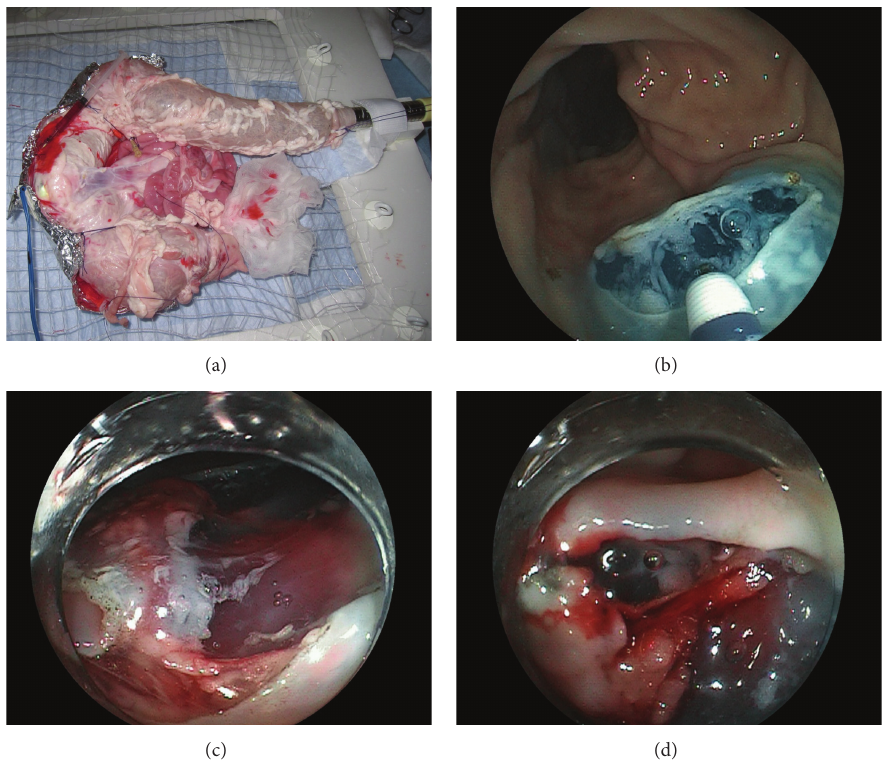
Figure 8: (a) Ex vivo blood flow animal model (Johnson & Johnson, Tokyo, Japan) for training for endoscopic hemostasis in colorectal endoscopic submucosal dissection. (b) Submucosal dissection was performed. (c) In the ex vivo blood flow model (bovine cecum), the submucosal vessels were visible. (d) Perioperative hemorrhage was stopped endoscopic coagulation with a